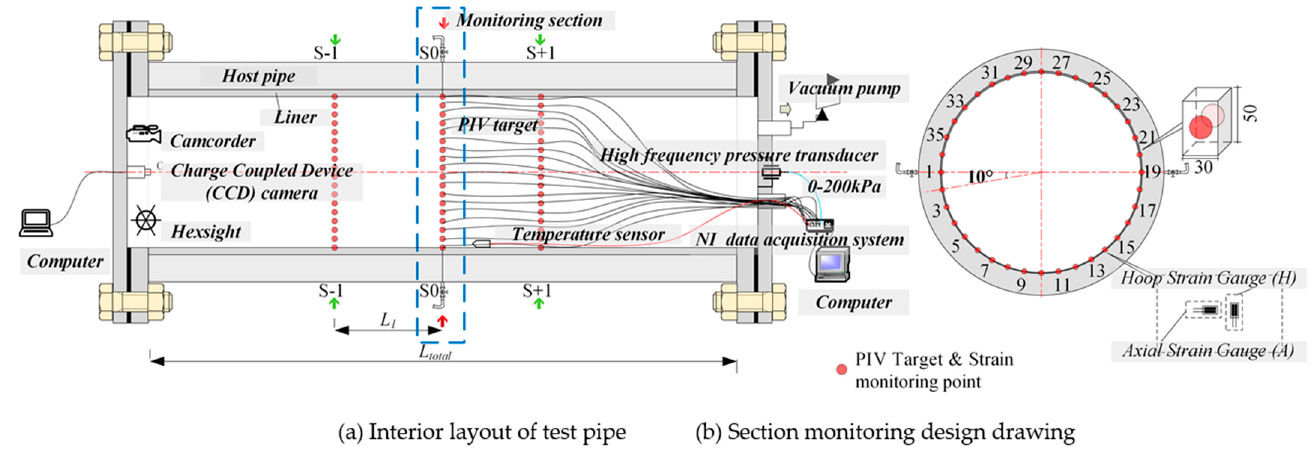
Figure 3. Experimental system.